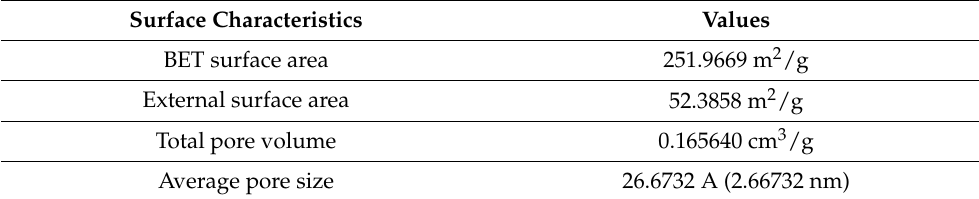
Table 2. BET Specific surface area and pore size of